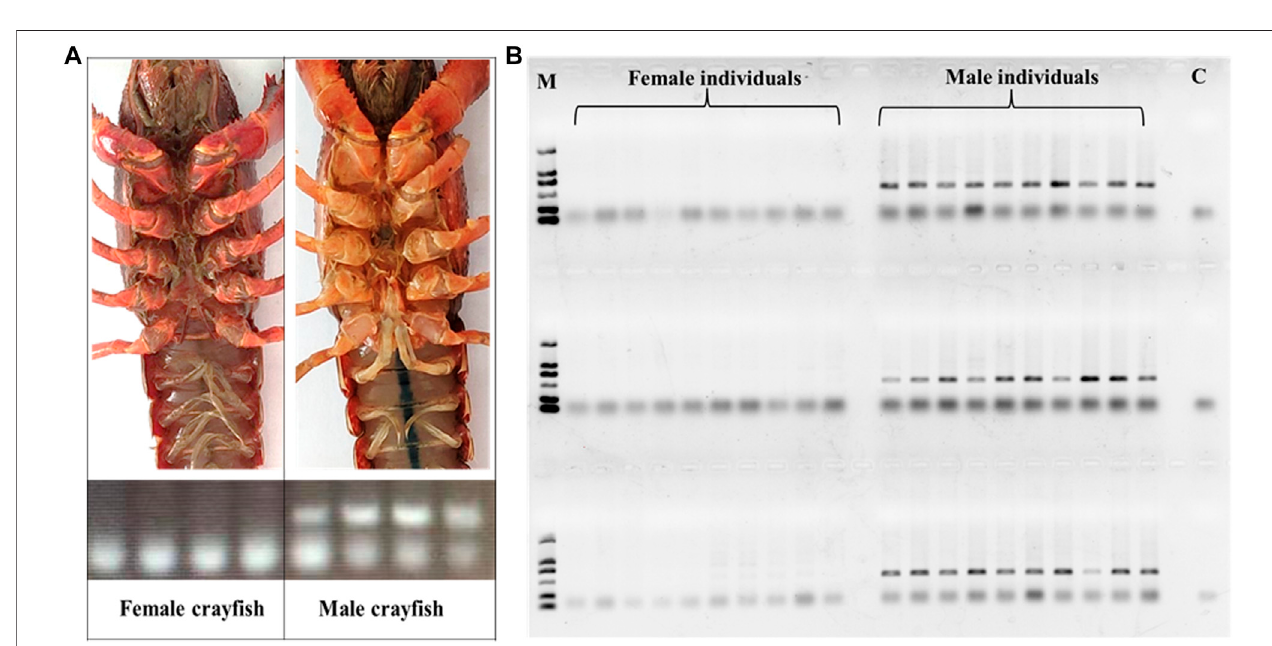
FIGURE3| Externalformof P.clarkii sexandPCRdetection. (A) Externalformof P.clarkii sexandPCRdetectionoffemaleandmaleindividuals. (B) PCRdetection of 30 females and 30 males of P. clarkii by the primer pair Marker7_F/R. M, D 2000 DNA marker; C, negative